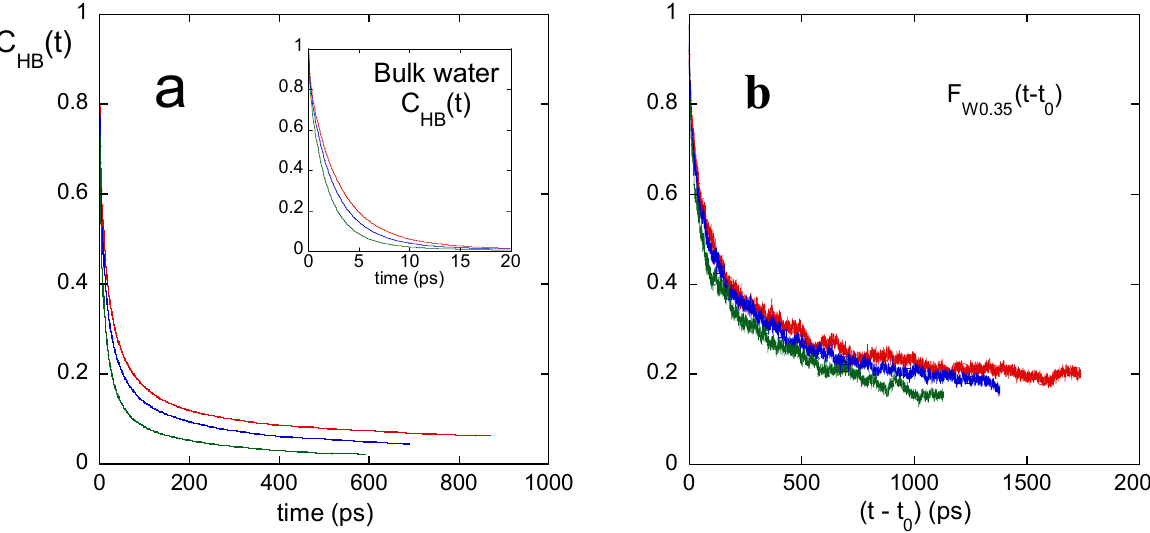
polymer. Inset: average autocorrelation function of hydrogen bonds in bulk water. (b) Time behavior of the fraction of water molecules residing in the first hydration shell of PVA at 283, 293 and 313 K (red, blue and green curves,